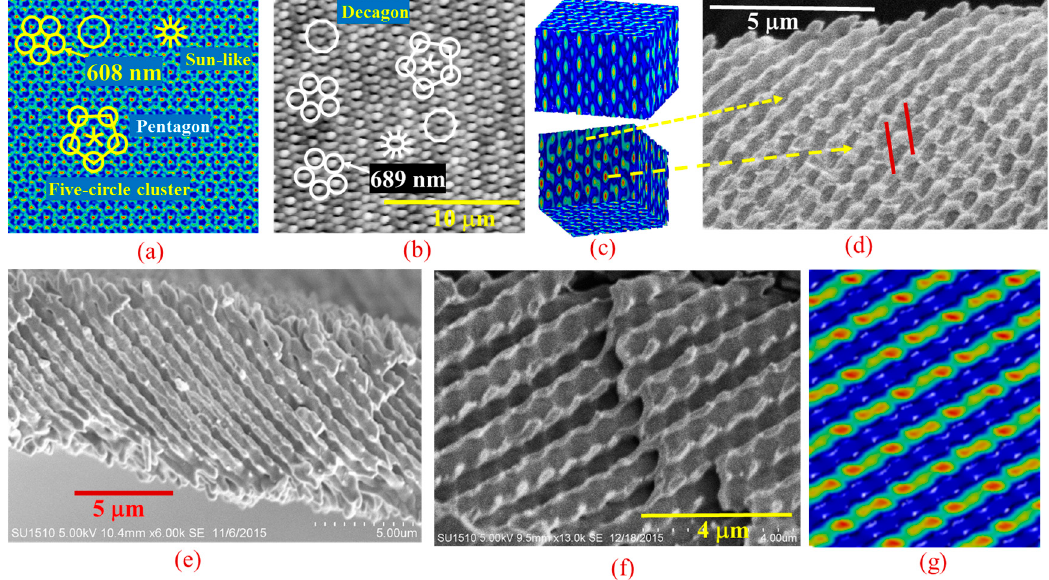
Figure 3. ( a ) Simulated top view of the 5 + 1 interference pattern and ( b ) atomic force micrograph (AFM) of fabricated quasi-crystals in DPHPA using a 5 + 1 configuration ROE. Five-circle clusters, pentagons, sun-like shapes of ten lines and decagons are drawn for eye guidance; ( c ) simulated interference patterns showing the front and back sides of a cubic volume; ( d – f ) cross-section SEM images of fabricated 3D quasicrystals in SU-8 cut in different orientation revealing various structural information; and ( g ) a side view of simulated 3D interference pattern due to 5 + 1 beams.